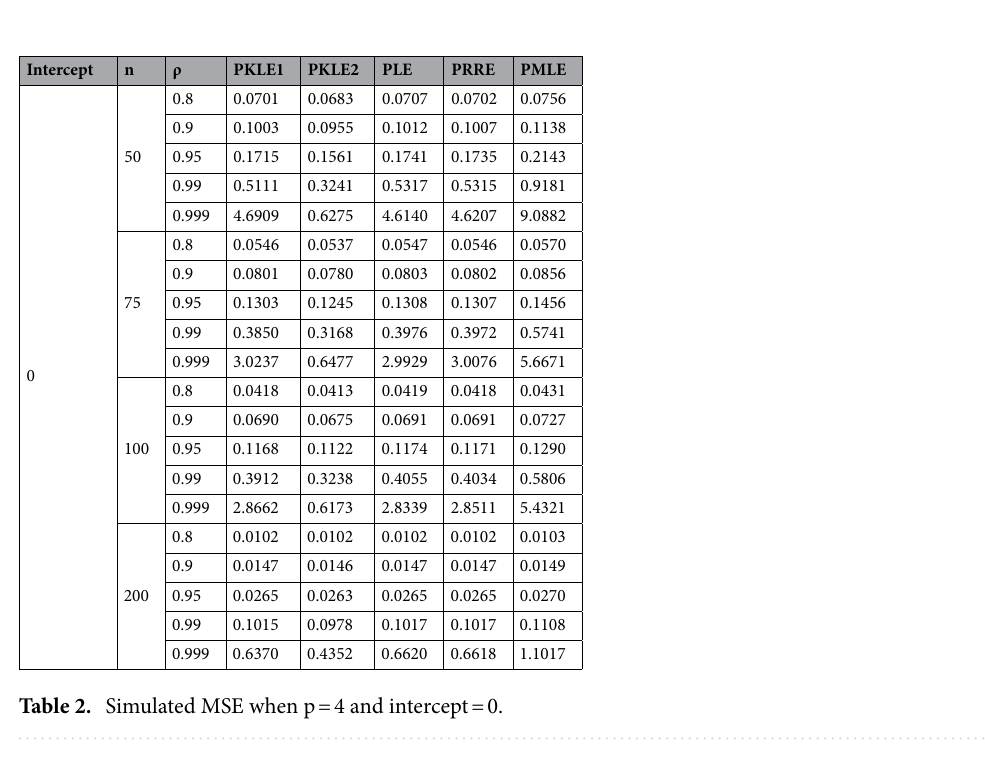
Table 1. Simulated MSE when p = 4 and intercept = − 1.